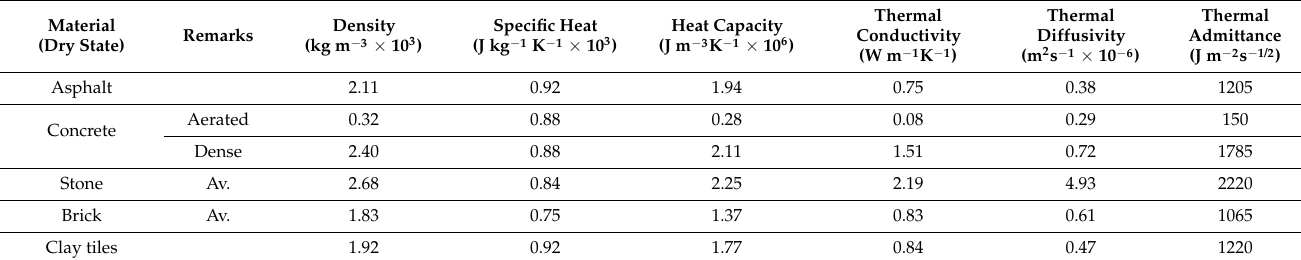
Table 2. Thermal properties of materials used in building and construction (Modified after Oke)